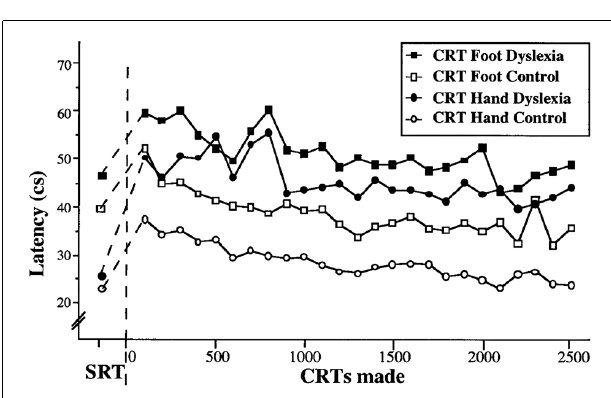
FIGURE 4 | Speed of primitive skill with